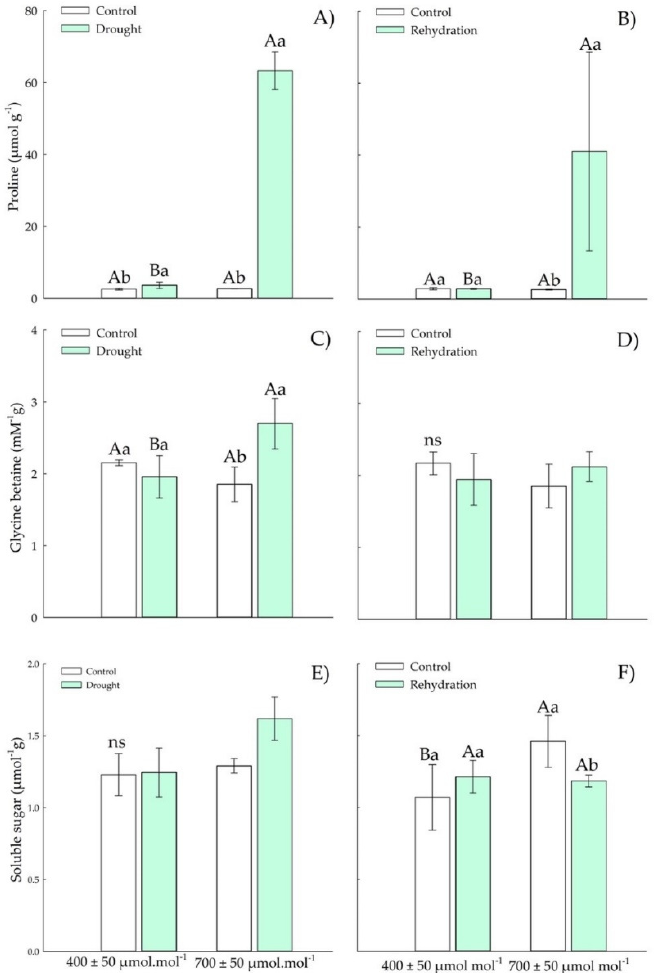
Figure 3. Effects of CO 2 concentration ( a [CO 2 ] = 400 µmol mol − 1 and e [CO 2 ] = 700 µmol mol − 1 ) and drought stress in A. buniifolius leaf proline ( A , B ), glycine betaine ( C , D ), soluble sugar ( E , F ) content. In plant sampled after drought stress ( A , C , E ) and rehydration ( B , D , F ) period. Different uppercase letters indicate a significant difference between values in different CO 2 within the same water treatment, while different lowercase letters indicate significant differences between values of different water treatments within each CO 2 level by Tukey’s test ( p ≤ 0.05). ns denotes non-significance ( p > 0.05). Error bars represent a 95% confidence